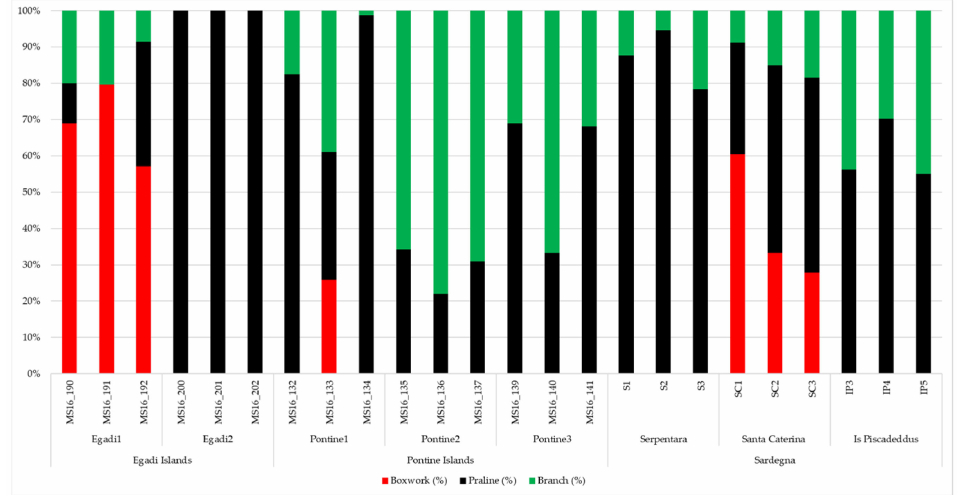
Figure 2. Bar graph with the morphotype coverage per station and site. Red is for boxwork, black is for pralines, and green is for branches.